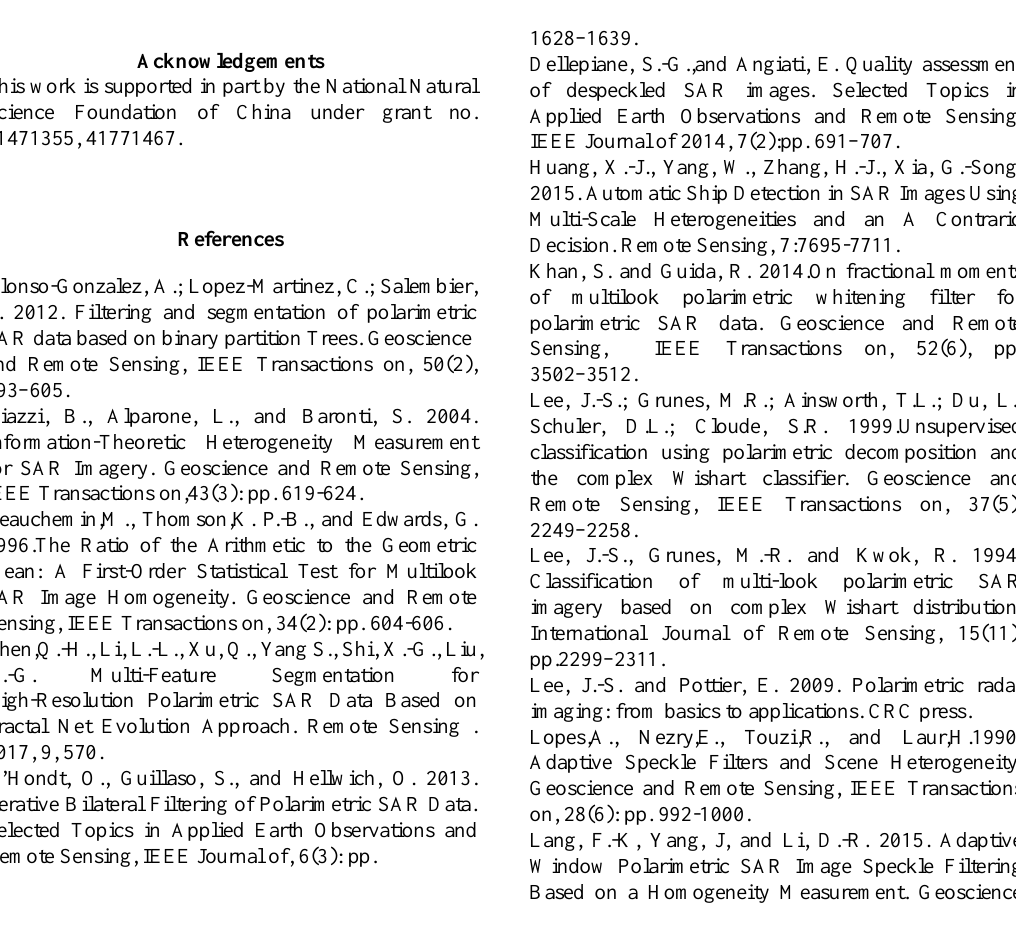
Figure 3. Comparison of the heterogeneity feature on ESAR data. From top to bottom are the heterogeneity images with ranging from 3 × 3 to 7 × 7. (a) CV;(b)A/G;(c)shape parameter;(d)the proposed